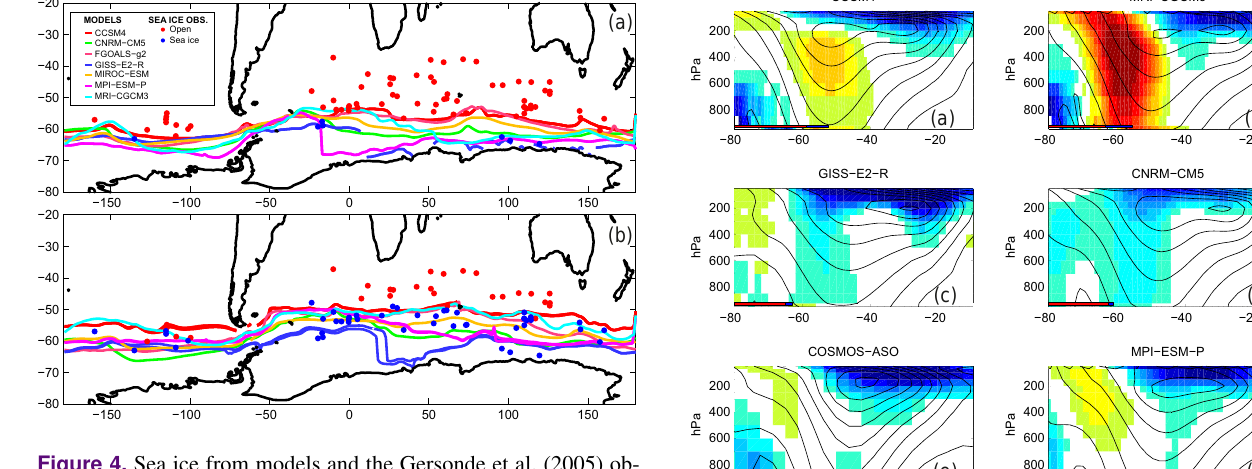
Figure 4. Sea ice from models and the Gersonde et al. (2005) ob- servations for (a) the PI and (b) the LGM. Coloured dots show open water (red) and inferred sea ice (blue). The differing coloured lines show the annual mean 15% sea ice extent for individual models. See legend for colours.